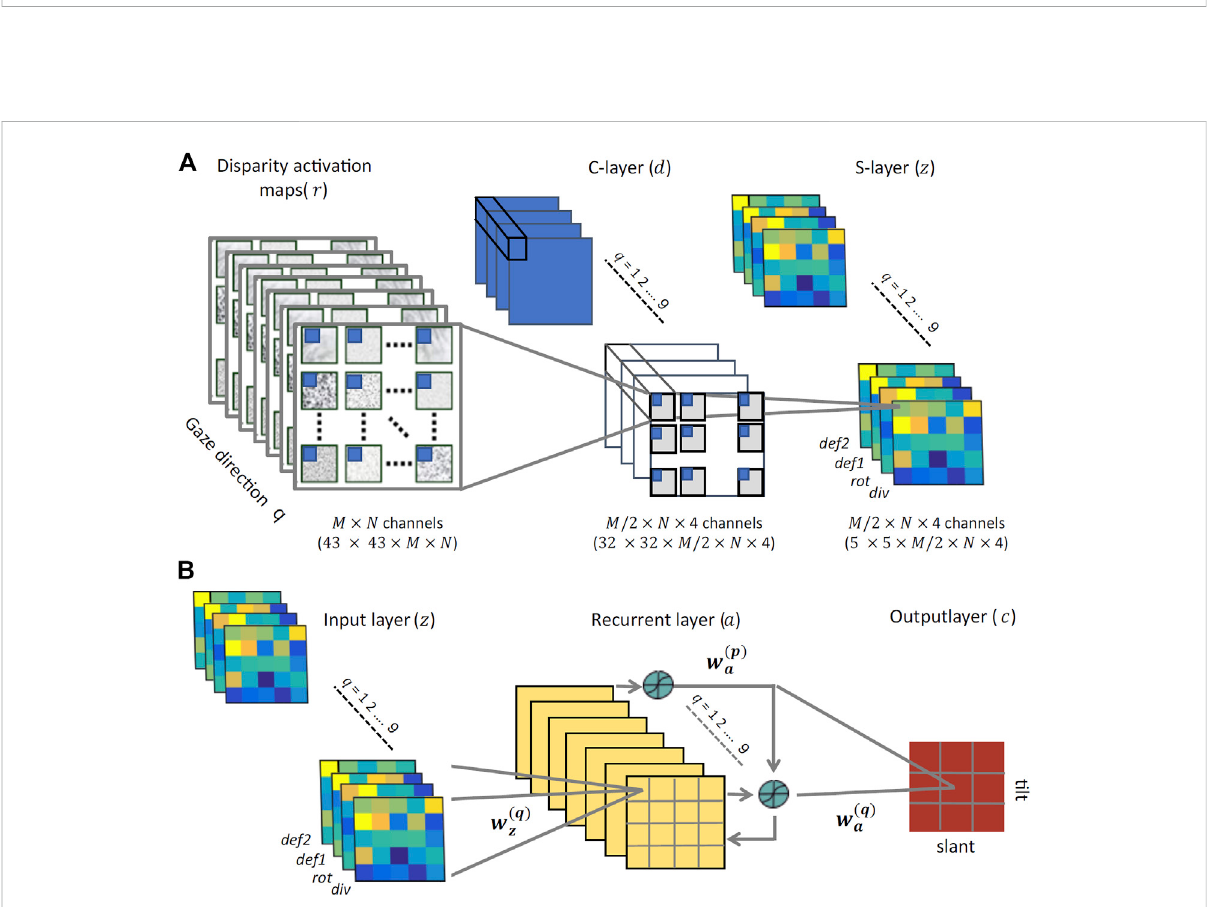
FIGURE 8 The proposed neural architecture (A) The non-trainable preprocessing module is a three-layer convolutional architecture that receives multidimensional disparity-related activation maps for each of the nine gaze directions, and provides a set of neural maps representing disparity differential elementary components (div, rot, def 1 , and def 2 ). (B) The trainable three-layer module that relies on recurrent connections between its hidden units to learn gaze-invariant disparity representations in the slant/tilt parametric space, from the input neural maps related to a set of different gaze